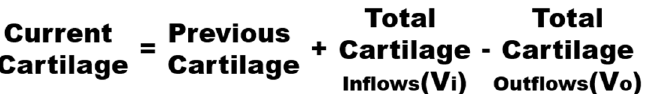
Figure 1. Schematic representation of cartilage on the flow, where Vi is the rate of regeneration and Vo is the rate of biodegradation. Since biopolymers are the main part of the dry extracellular matrix, therefore, the cartilage condition could be described in terms of (Vi—Vo). In the outcome of